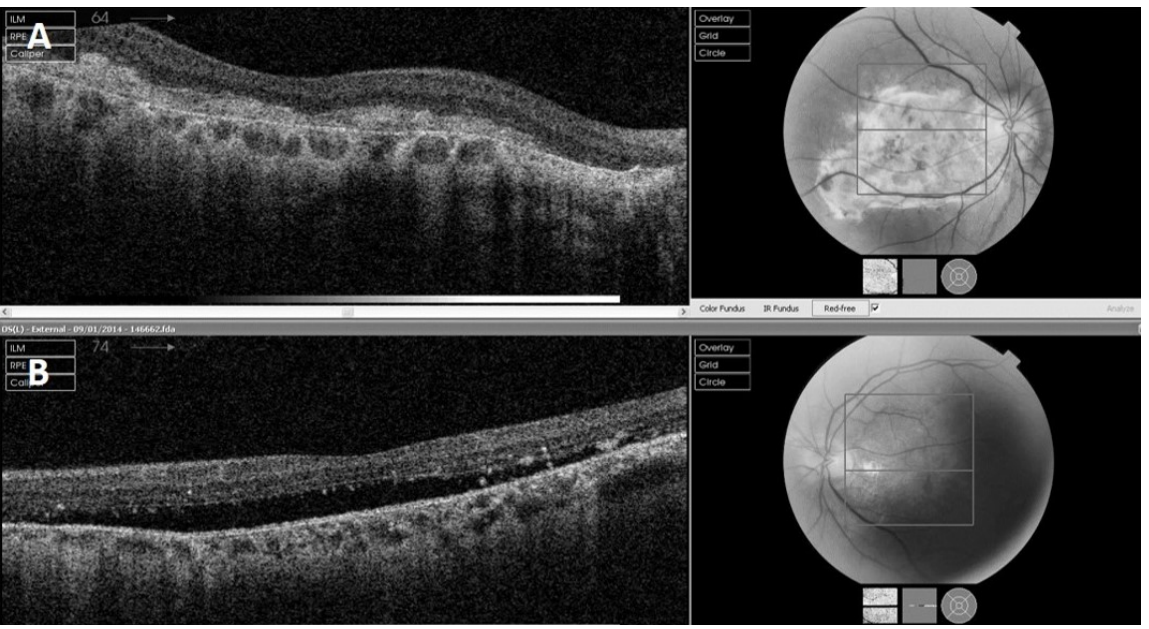
Figure 1: A) Right eye showing disciform scar at initial presentation. B) Left eye showing neurosensory elevation at initial presentation.